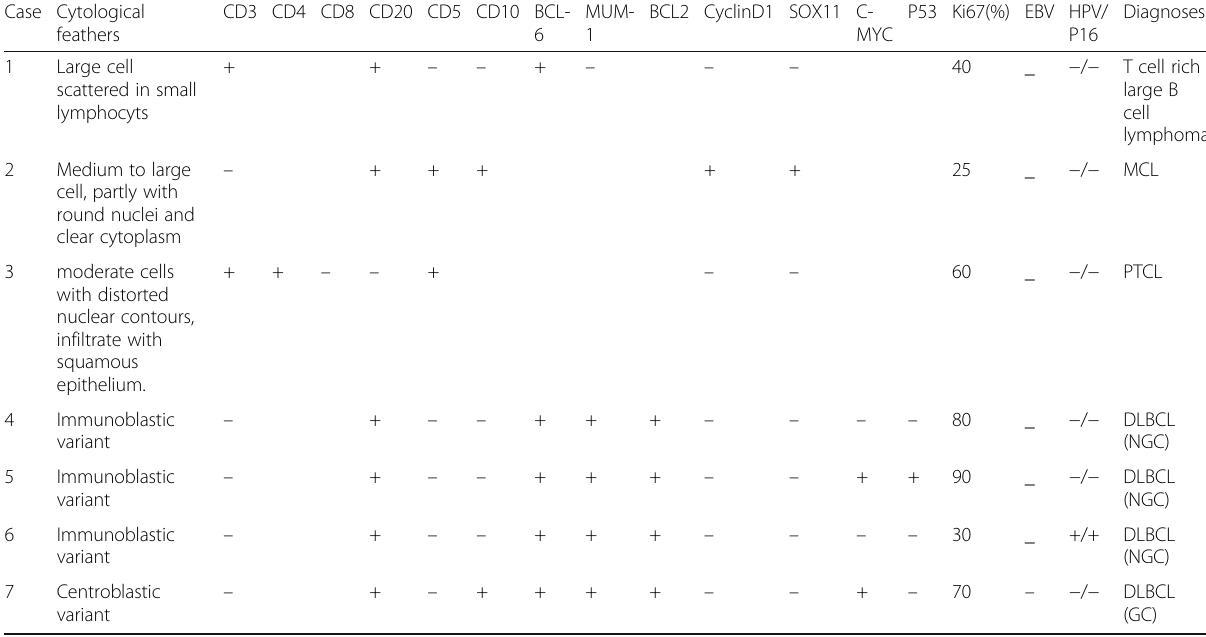
Table 2 Summary of pathological characters of tongue lymphomas Case Cytological